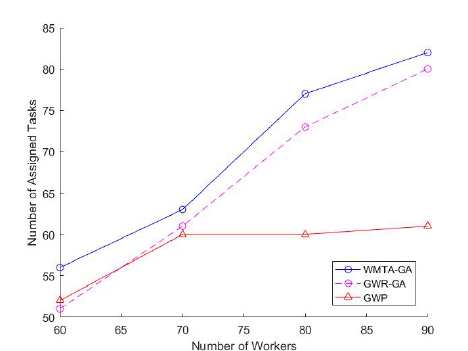
Figure 5. Impact of Varying Number of Workers on Number of Assigned